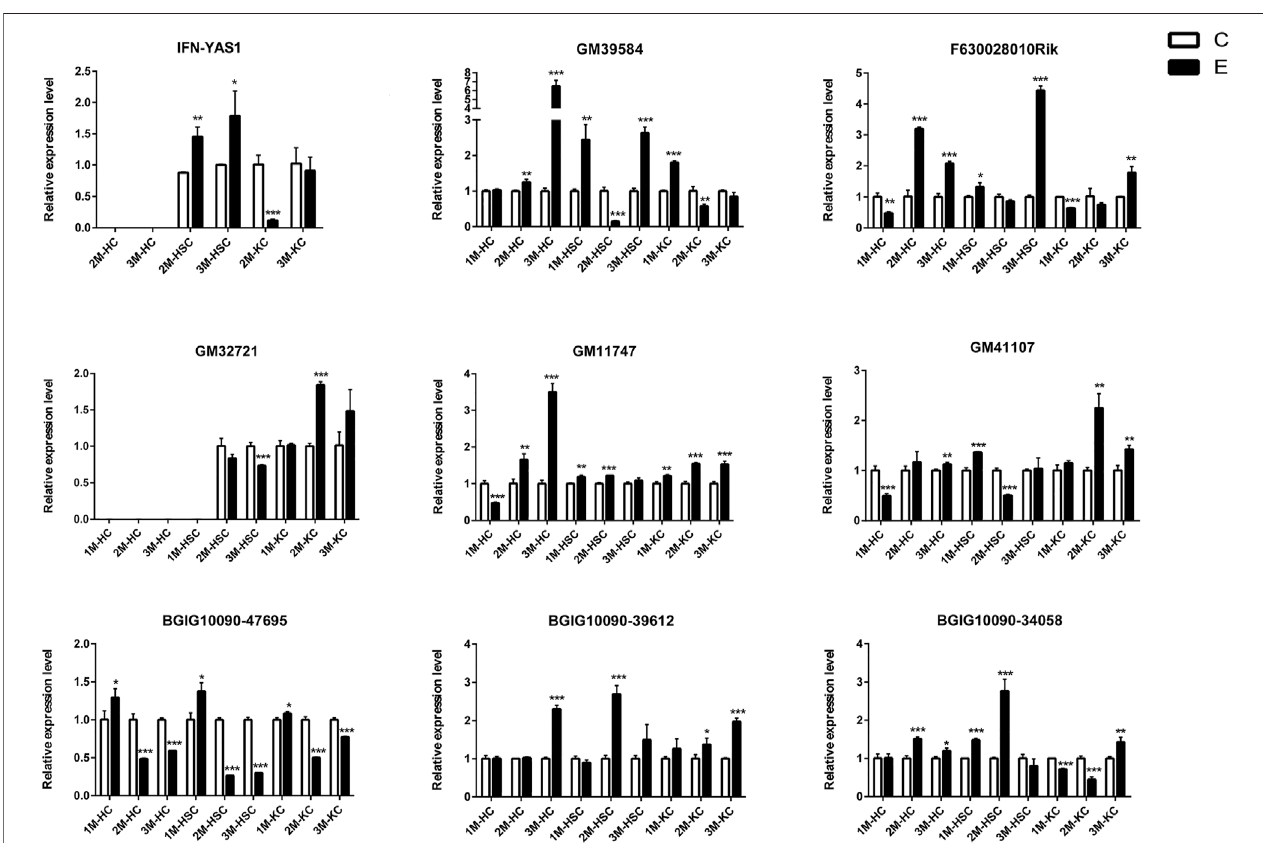
FIGURE4| Therelative expression levels of9lncRNAs in2M-HC, 3M-HC, 2M-HSC, 3M-HSC,2M-KCand 3M-KC weredetermined byqRT-PCR.Thenumberof biologicalreplicates foreach experimentwas3and therelative expression levels werenormalized totheexpression levels ofGAPDH.Dataarepresented asmeanswith SD. p -values were analyzed by Student ’ s t -test. *** p < 0.001, ** p < 0.01 and * p < 0.05.